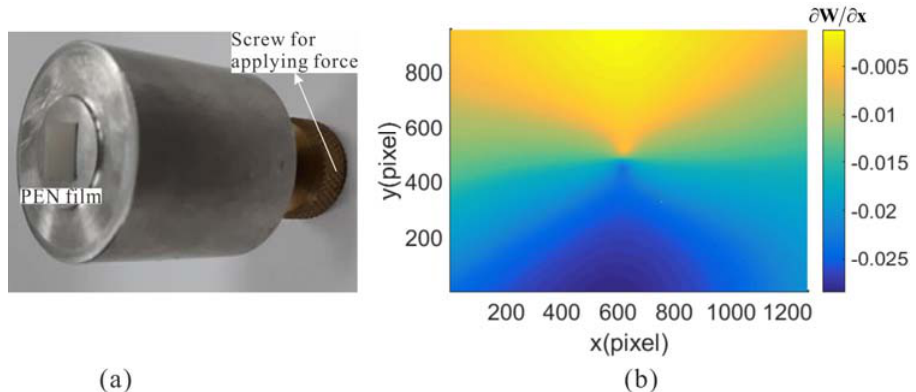
Figure 4. ( a ) PEN film and mount of the film; ( b ) measured strain of the